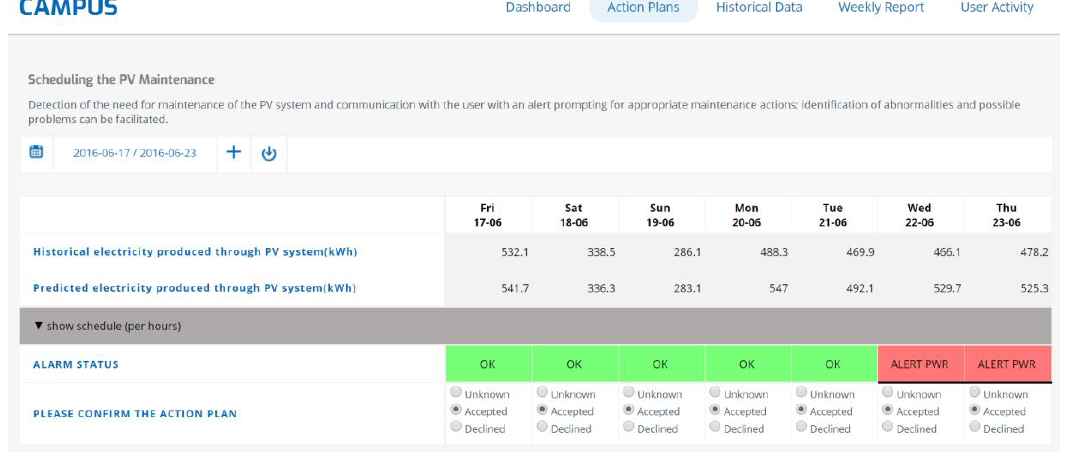
Figure 3. Scheduling the PV maintenance in the Savona Campus.